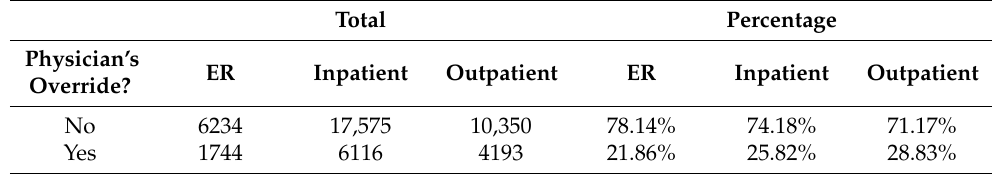
Table 8. Alerts and override by visit